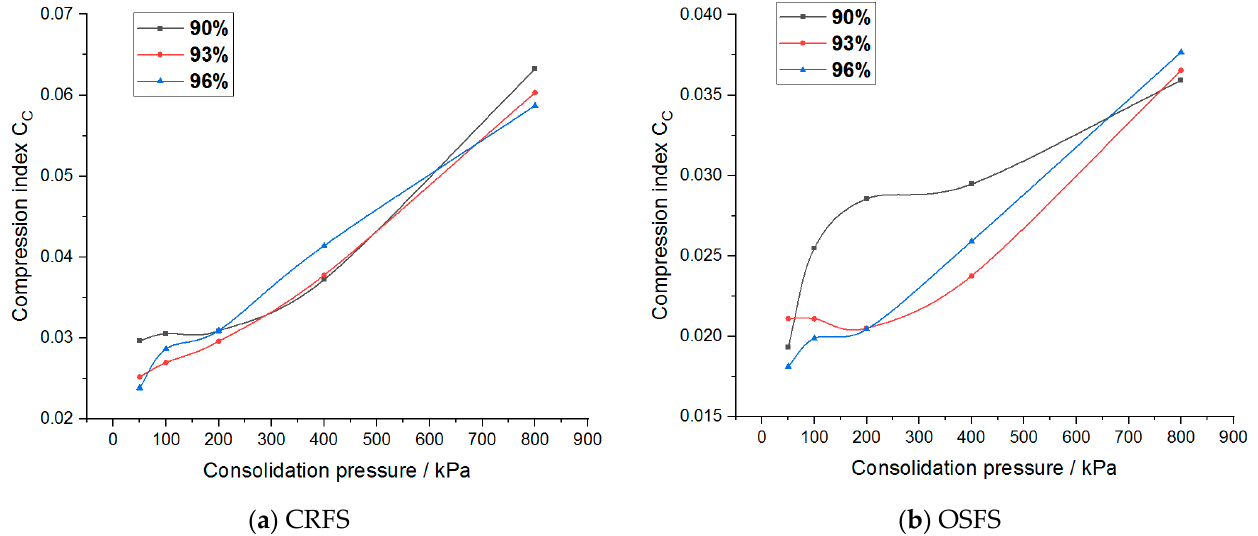
Figure 17. Compression index of modified soil with different compaction degrees.